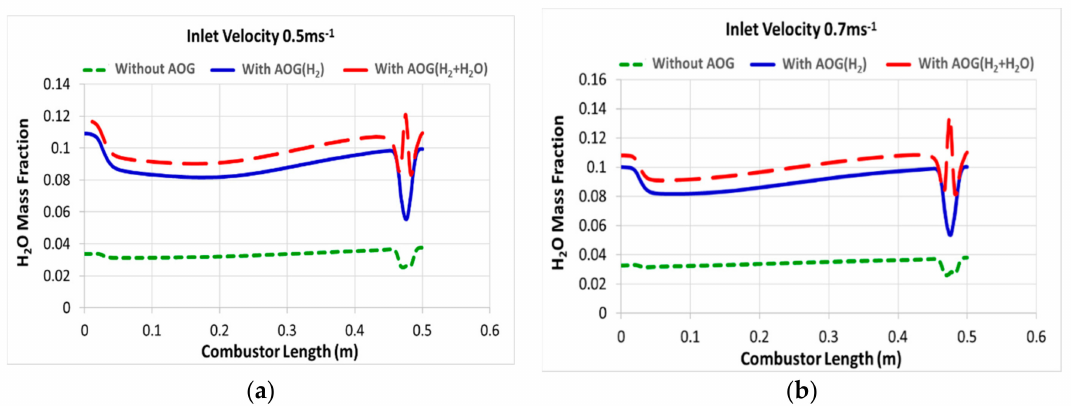
Figure 10. Line plots of H 2 O mass fraction varying as a function of combustor length at ( a ) 0.5 m / s and ( b ) 0.7 m / s inlet velocity for all the three